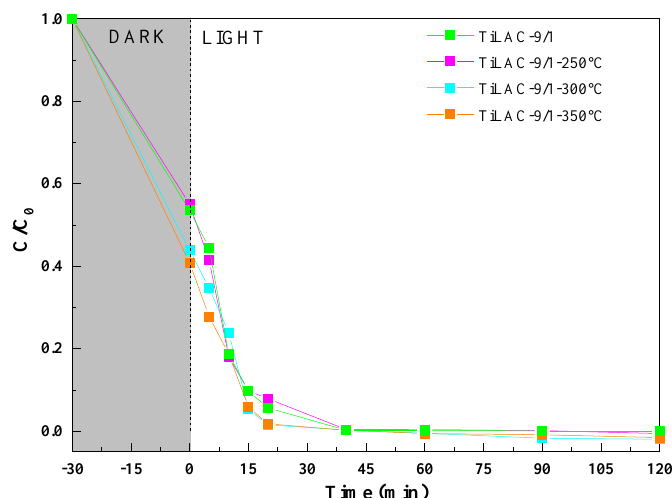
Figure 9. Methylene blue removal on TiLAC catalysts, TiLAC-9/1, TiLAC-9/1 – 250 °C, TiLAC-9/1 – 300 °C, TiLAC-9/1 – 350 °C heat treated at different temperatures under dark and with UV-irradiation.